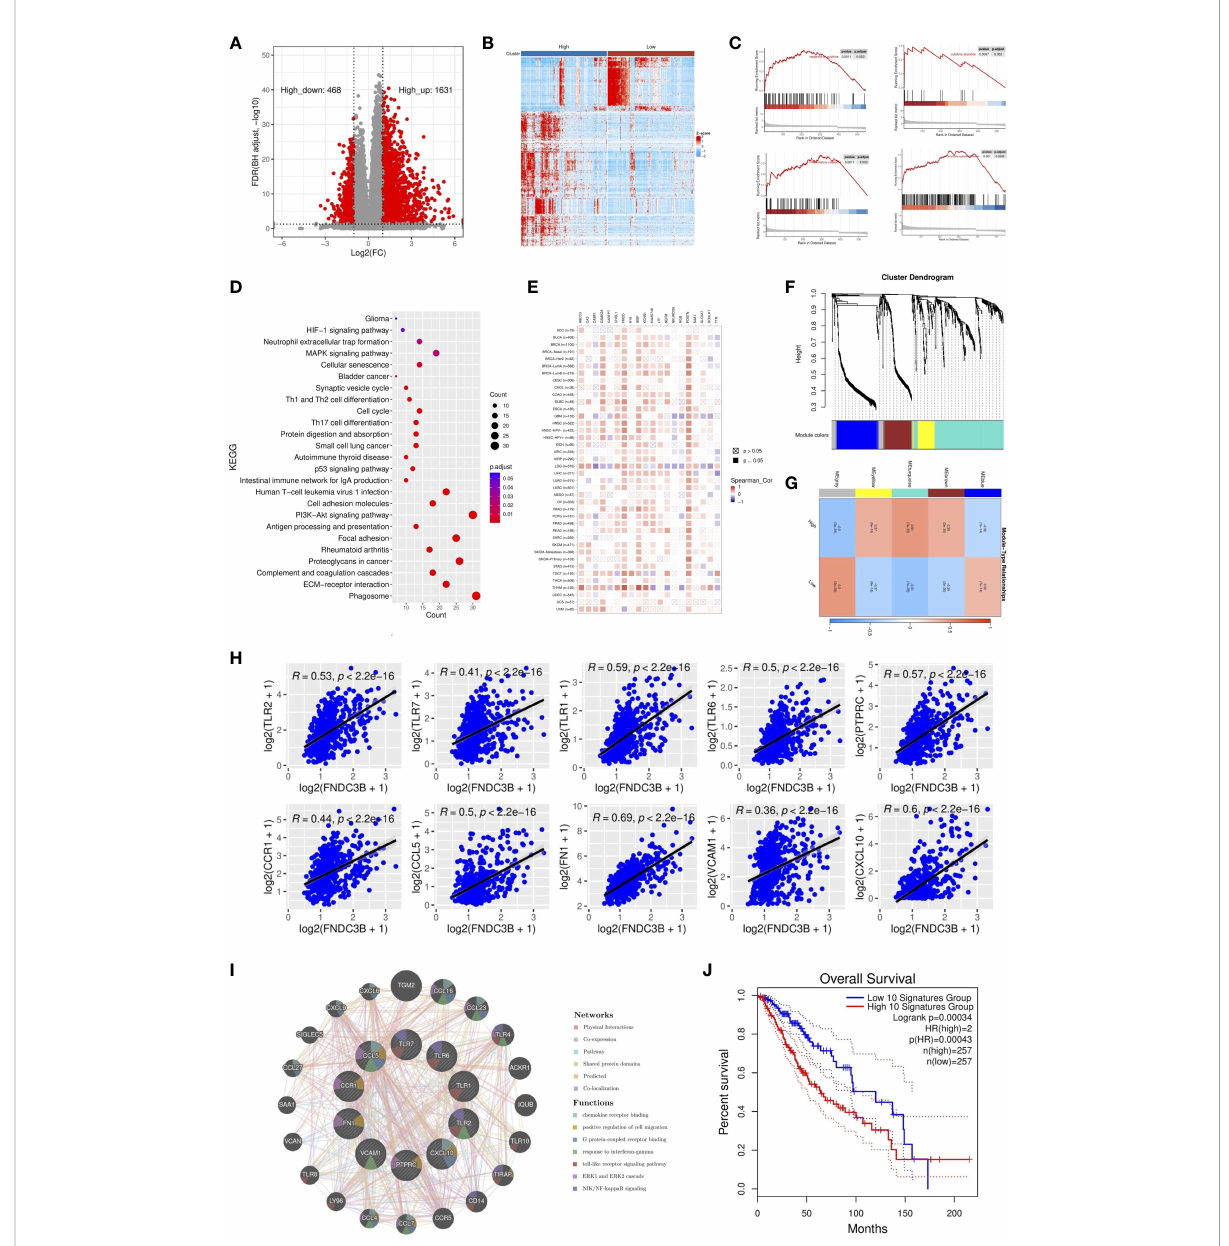
FIGURE 4 Identi fi cation and enrichment analysis of differentially expressed genes (DEGs) in TCGA low-grade glioma (LGG). (A) Volcano plot of all DEGs. (B) Heatmap of the 547 fi ltered DEGs. (C) Gene set enrichment analysis (GSEA) showed that FNDC3B is involved in the tumor immune microenvironment. (D) Kyoto encyclopedia of genes and genomes (KEGG) pathway analyses of DEGs. (E) The correlation heatmap between FNDC3B with 20 DEGs in pan-cancer. TCGA: The Cancer Genome Atlas. (F) Co-expression network constructed with weighted gene co- expression network analysis (WGCNA), hierarchical clustering tree for DEGs based on a dissimilarity measure (1-TOM), genes with similar expression patterns were merged into the same module. (G) Correlation between modules and FNDC3B expression. The upper number in each grid represents the correlation coef fi cient of each module, and the lower number is the corresponding P-value. (H) Relationship of the expression level between the top 10 hub genes and FNDC3B. (I) GeneMANIA database analysis shows the interaction network among hub genes. Each node represents a gene. The node size displays the strength of interactions. The line color indicates the types of interactions and the node color represents the possible functions of each gene. (J) The survival times of TCGA low-grade glioma (LGG) patients with the highest and lowest expression of the top 10 hub genes were